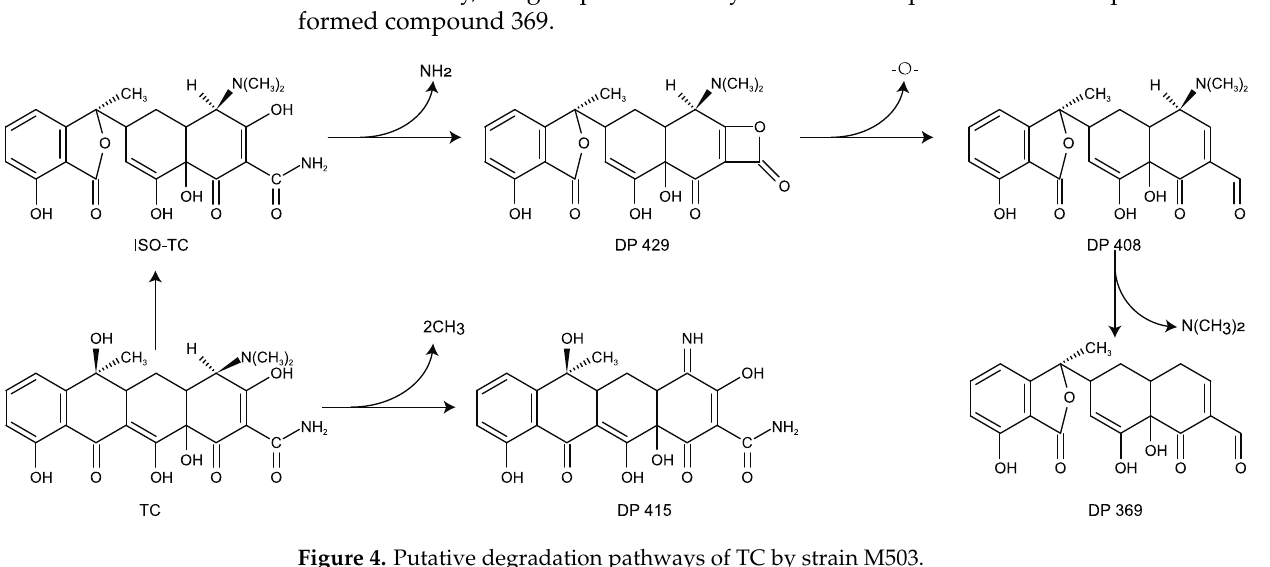
Figure 4. Putative degradation pathways of TC by strain M503.